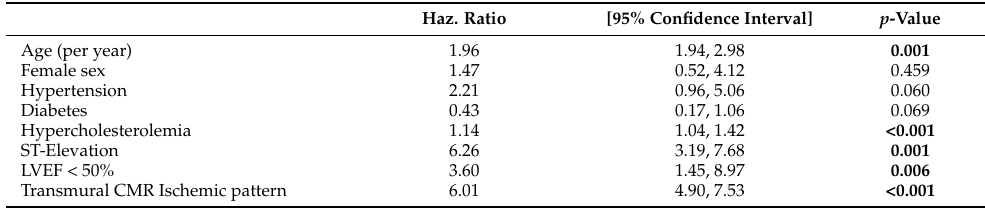
Table 3. Independent predictors of cardiac-related rehospitalizations: the new occurrence of acute myocardial infarction (AMI), heart failure (HF), or arrhythmias. Haz. Ratio [95% Confidence Interval] p -Value